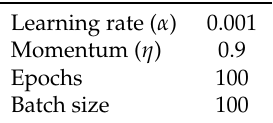
Table 4. Neural Network